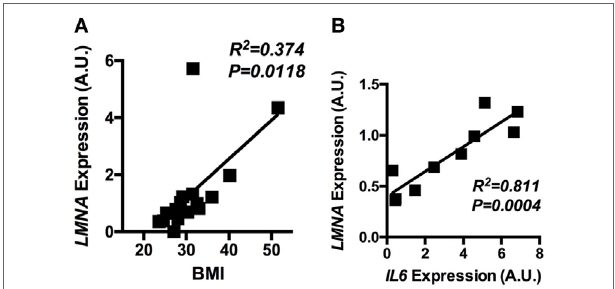
FigUre 7 | The adipose LMNA expression levels correlate with BMI and IL6 expressions in human subjects. Human omental adipose tissue samples were obtained by surgical biopsy from 30 individuals, and LMNA and IL6 mRNA levels were determined by quantitative real-time RT-PCR. Linear regression analyses of LMNA mRNA level in human omental adipose tissue with respect to (a) BMI and (B) IL6 mRNA levels are presented. Pearson’s correlation coefficients ( r ) between LMNA and either BMI or IL6 level are presented in each